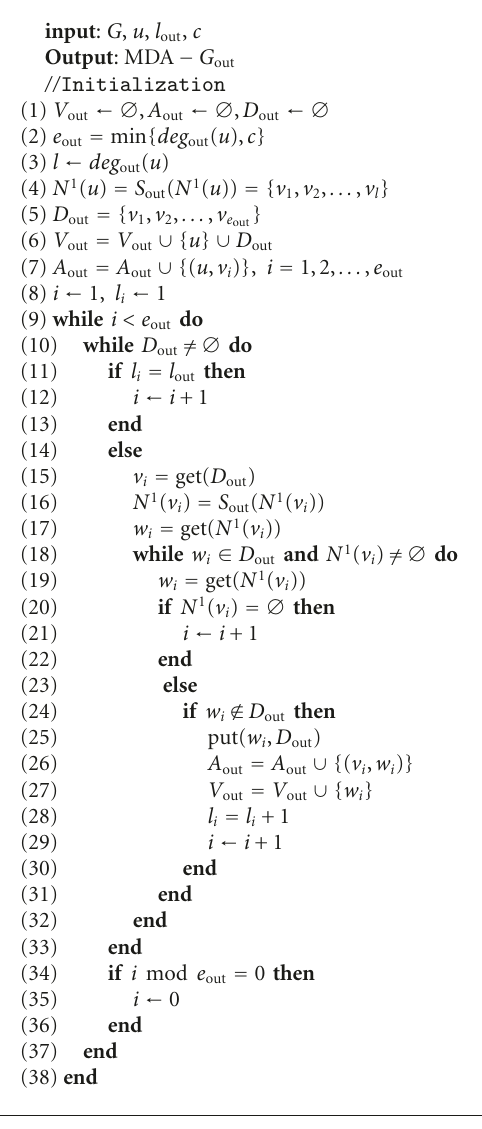
Algorithm 1: MDA – G out